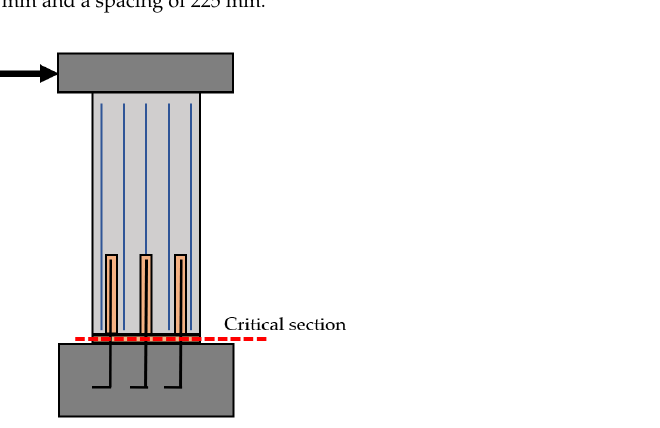
Figure 6. Potential critical cross-section of rectangular lightly reinforced precast walls.